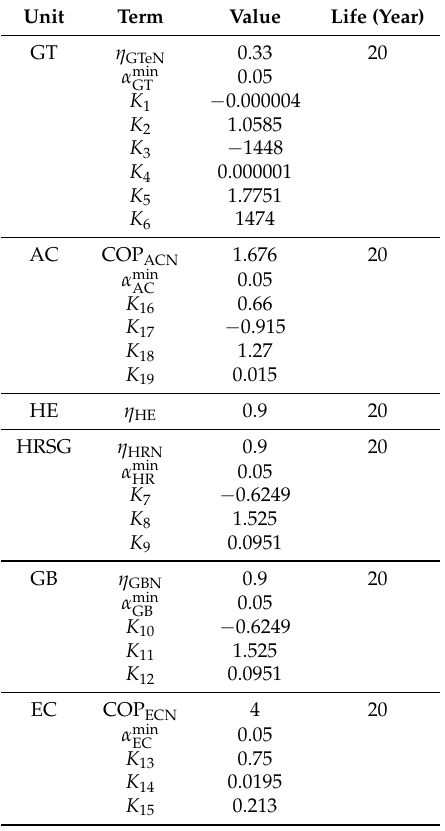
Table 4. The technical parameter settings of the EH.